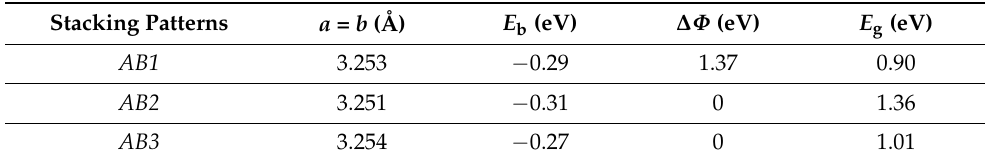
Table 1. Detailed information of Janus WSSe bilayers with different stacking patterns. Calculated lattice constants ( a and b ), binding energy ( E b ), surface potential energy difference ( ∆ Φ ), and band gap ( E g